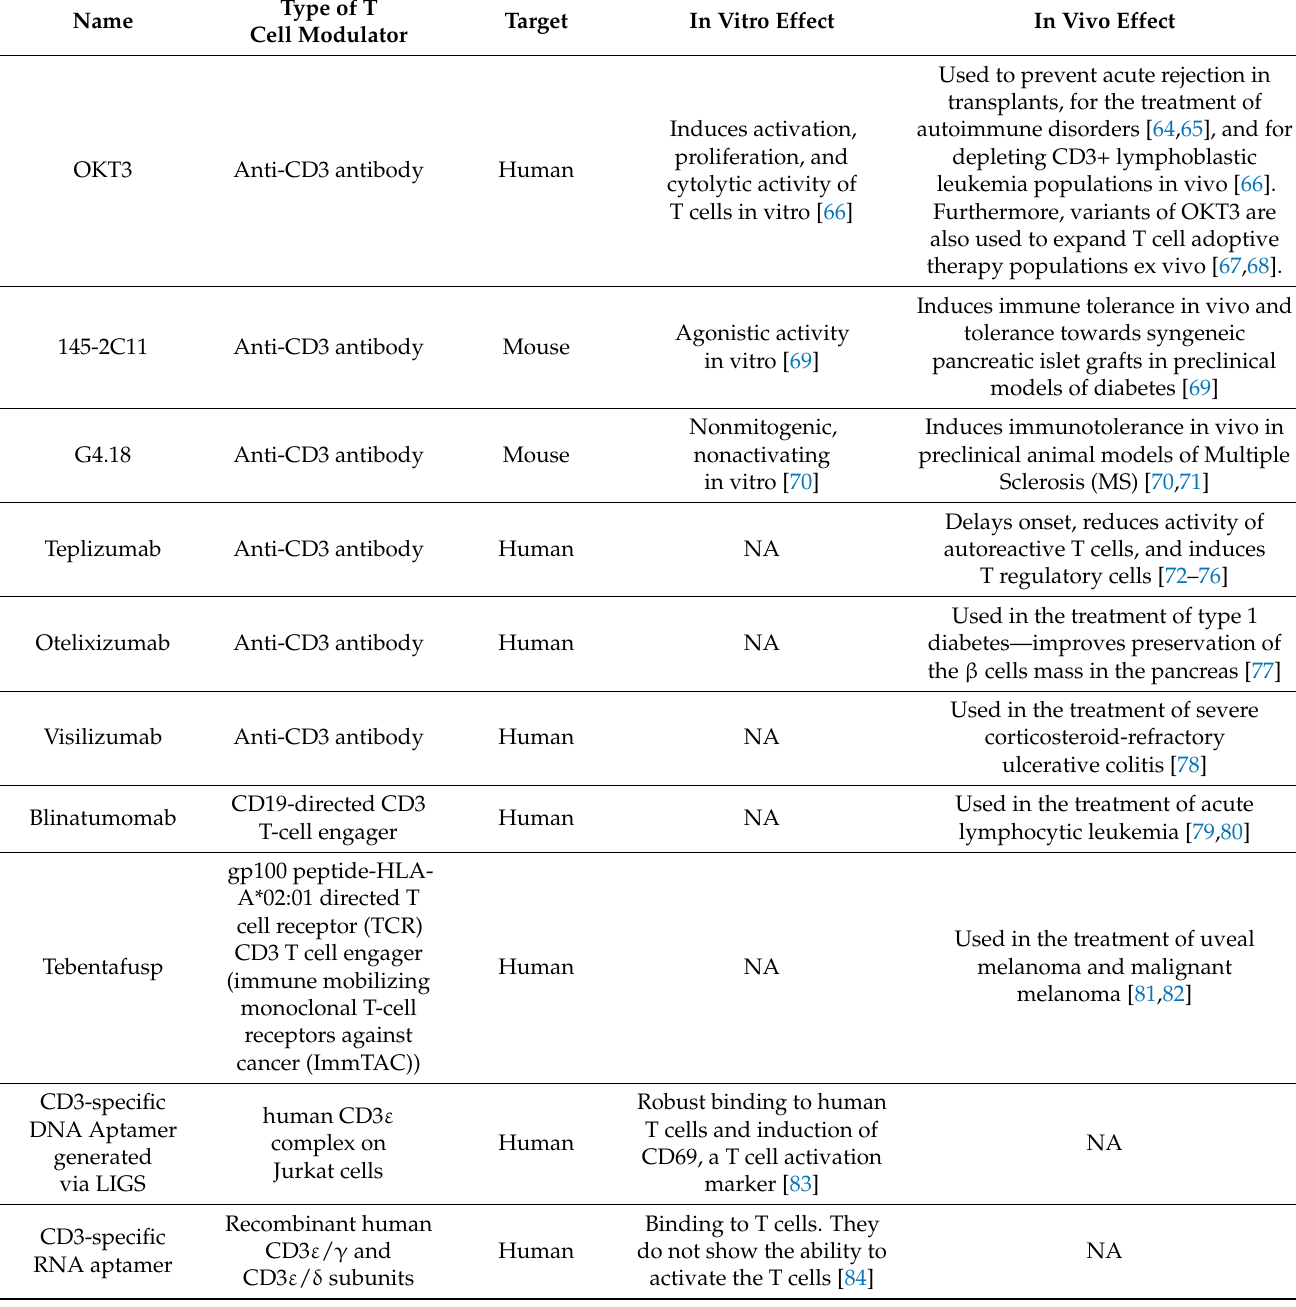
Table 1. Selected summary of preclinical and clinical uses of CD3